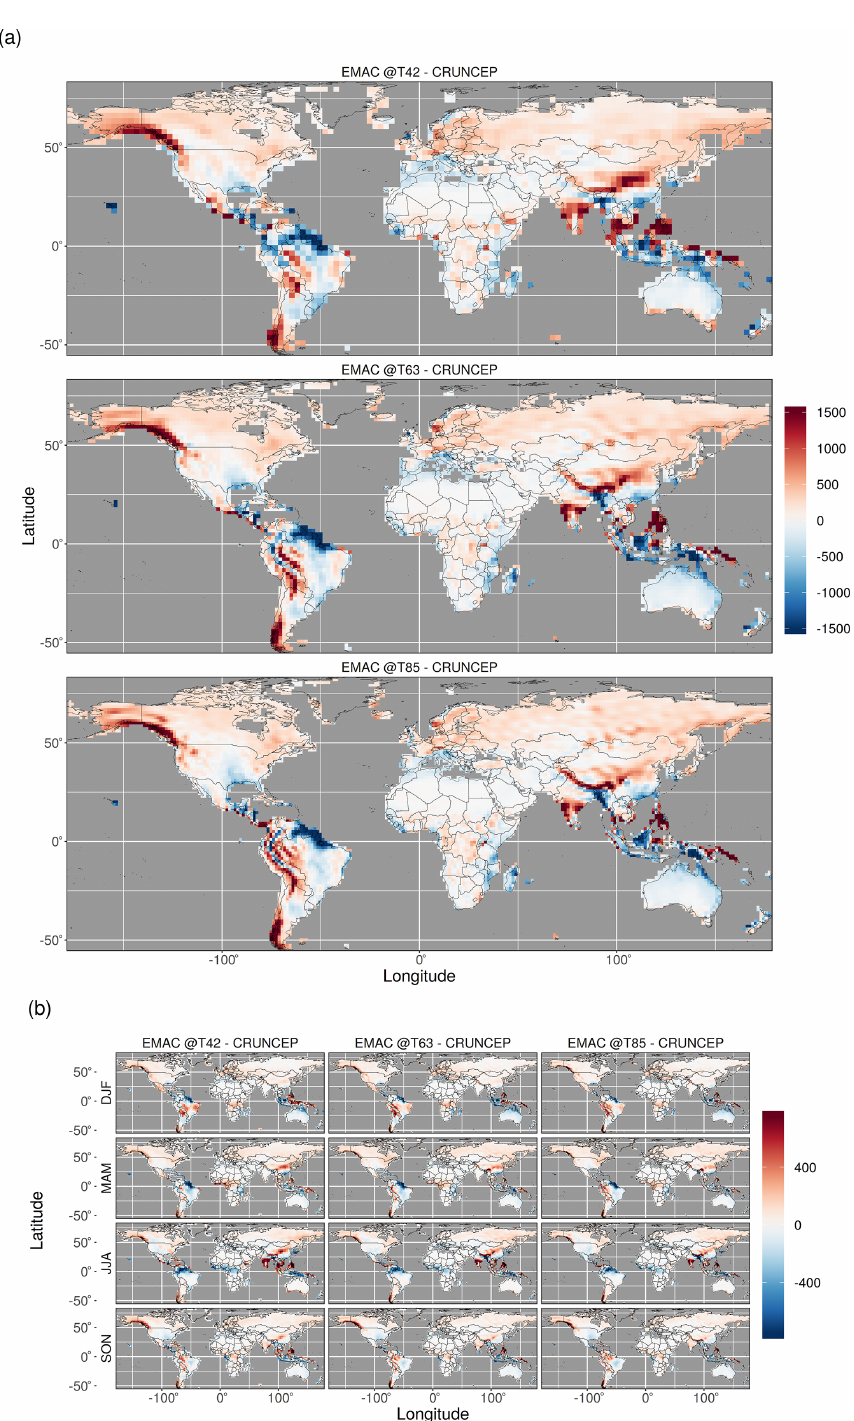
Figure C1. The (a) mean annual precipitation bias and (b) mean seasonal precipitation bias between the observed CRUNCEP dataset (1981– 2010) and EMAC simulations (last 50 years of simulation). Note that to ensure visibility of relatively low-precipitation biases, the plotted values are capped at 750mm per season and 1500mmyr − 1 in the seasonal and annual plots,